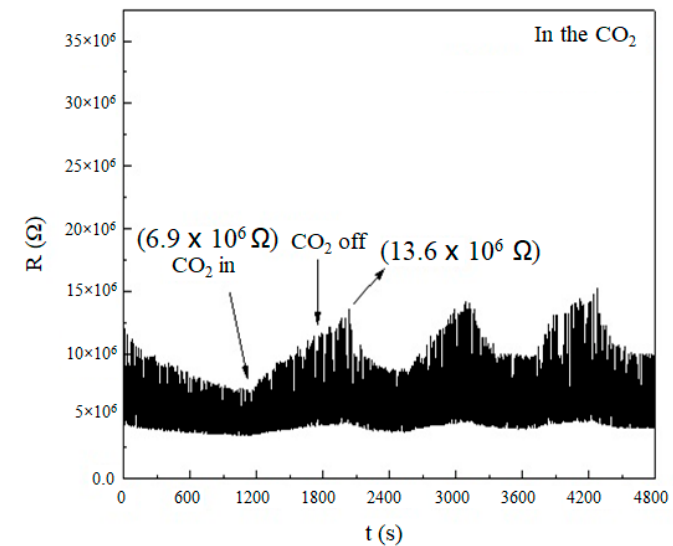
Figure 7. The result was for sensing the CO 2 by using SnO nanowires on the platinum interdigitated electrode sensing element.